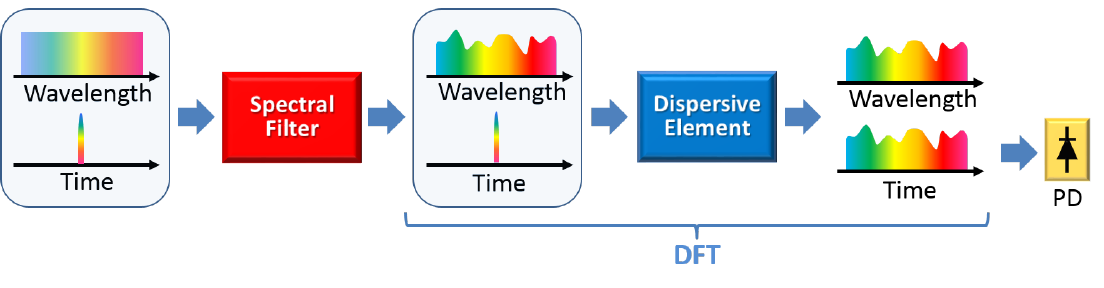
Figure 5. Schematic diagram to show microwave arbitrary waveform generation based on spectral shaping and DFT. PD: